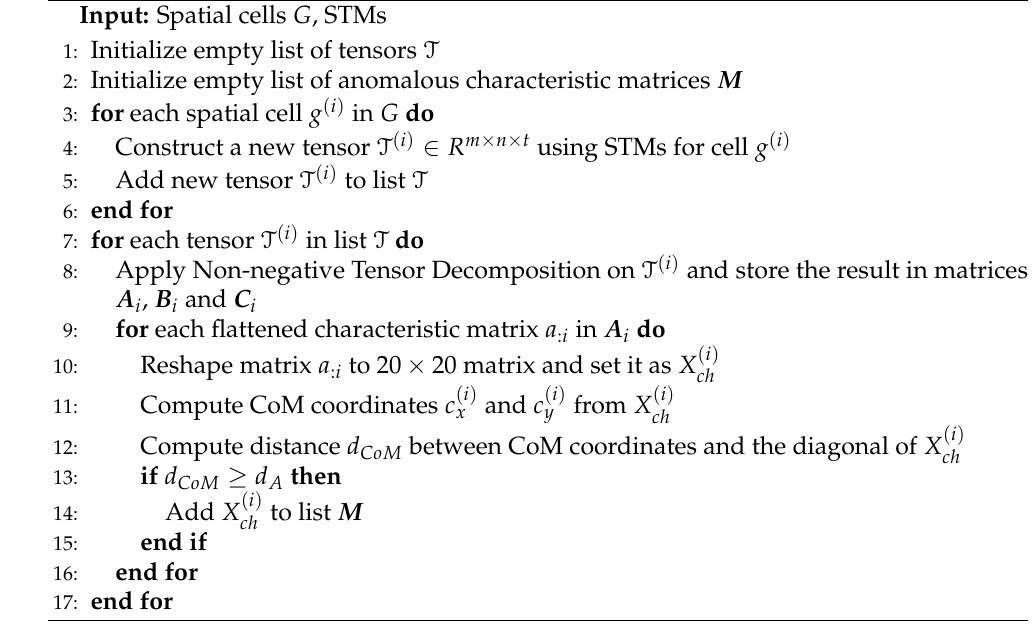
Algorithm 1 Tensor-based anomaly detection pseudo